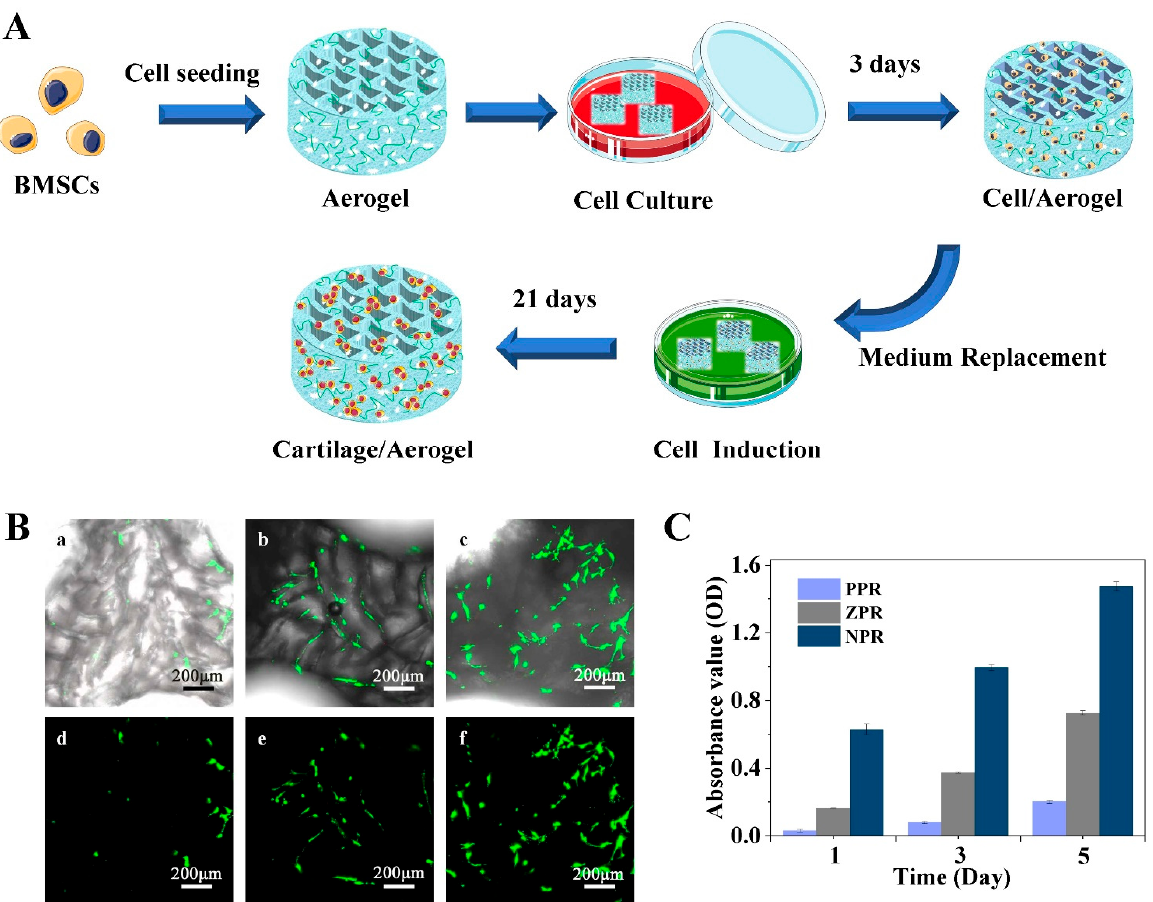
Figure 5. ( A ) Schematic diagram of mouse bone marrow mesenchymal stem cells (mBMSCs) cultured and induced on CNF/PEGDA scaffolds. ( B ) Confocal laser scanning microscopy (CLSM) images of mBMSCs cultured for 3 days in CNF/PEGDA aerogels with different Poisson’s ratios: ( a , d ) PPR; ( b , e ) ZPR; ( c , f ) NPR. ( C ) Proliferation of mBMSCs cultured for 1, 3 and 5 days in CNF/PEGDA aerogels with different Poisson’s ratios.